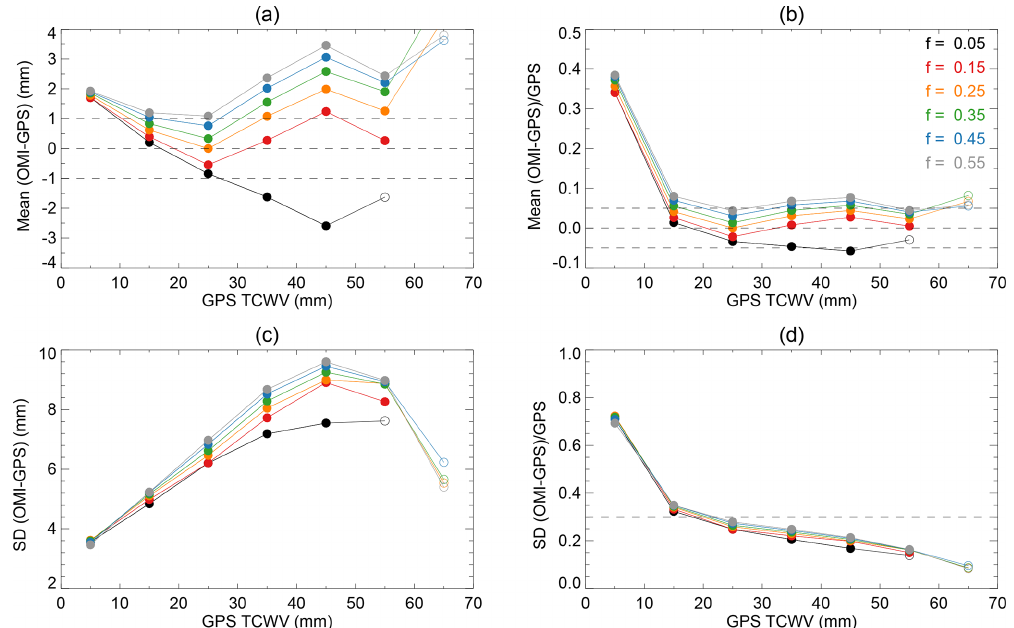
Figure 5. Parameters for each 10mm TCWV bin. Curves with different colors are for different cloud fraction thresholds f as indicated in (b) . The OMI filtering criteria remain the same as those for Figs. 3 and 4. Symbols are filled if the fraction of data pairs within the TCWV interval is > 1% of all the available data pairs and are open otherwise. The parameters are (a) mean OMI–GPS in millimeters, (b) relative bias defined as mean (OMI–GPS) / GPS, (c) the standard deviation ( σ ) of OMI–GPS in millimeters and (d) relative scatter defined as σ / GPS. Results are for all days in 2006. Dashed lines are meant to facilitate visualization.